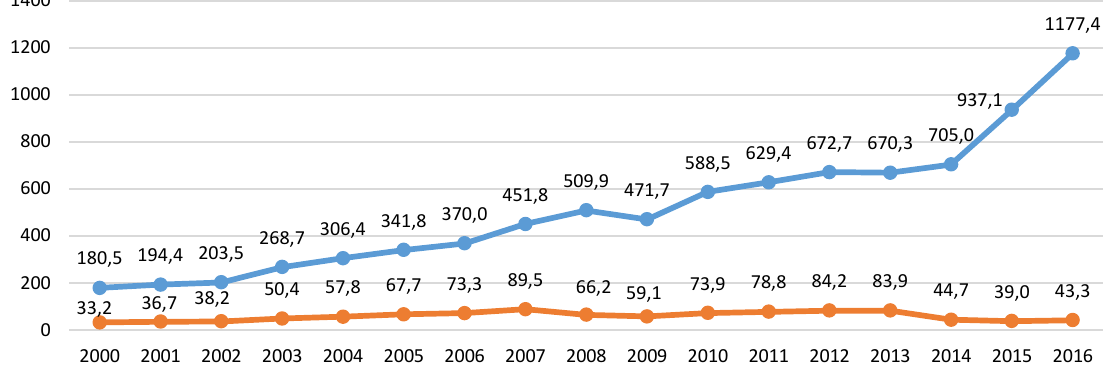
Figure 3. Adjusted statistical set of data of small business sales volume in 2000–2016 calculated in national currency and in dollars